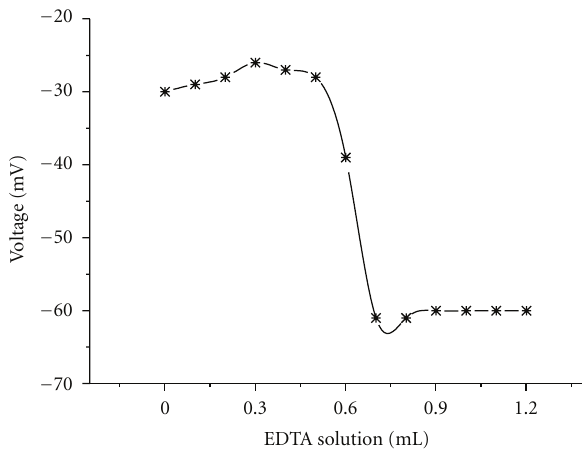
Figure 7: The potentiometric titration curve of thallium (I) ion sensor for 18 mL of 2 × 10 − 3 M thallium nitrate solution with 5 × 10 − 2 M solution of